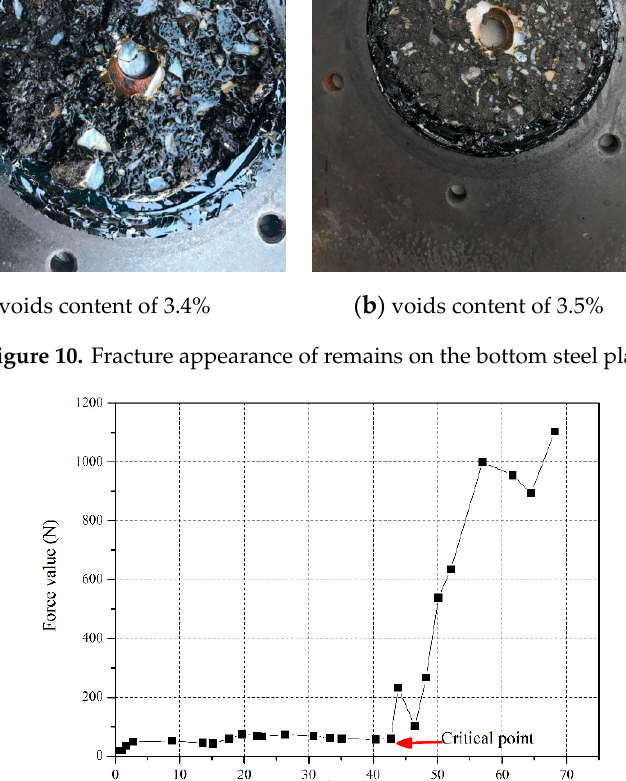
Figure 11. Test process for the specimen with a voids content of 4.0%.